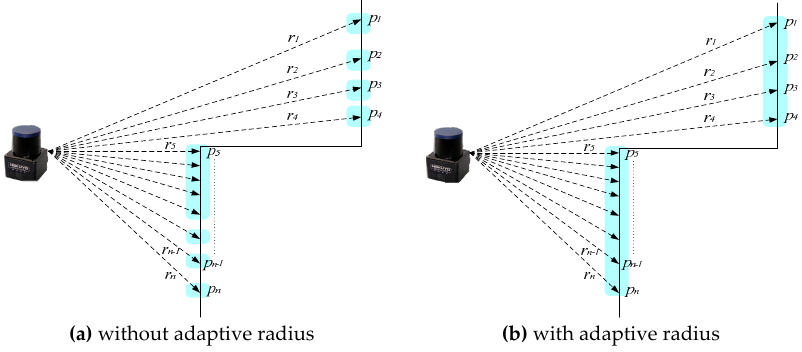
Figure 2. Illustration of the adaptive radius clustering (ARC) algorithm.